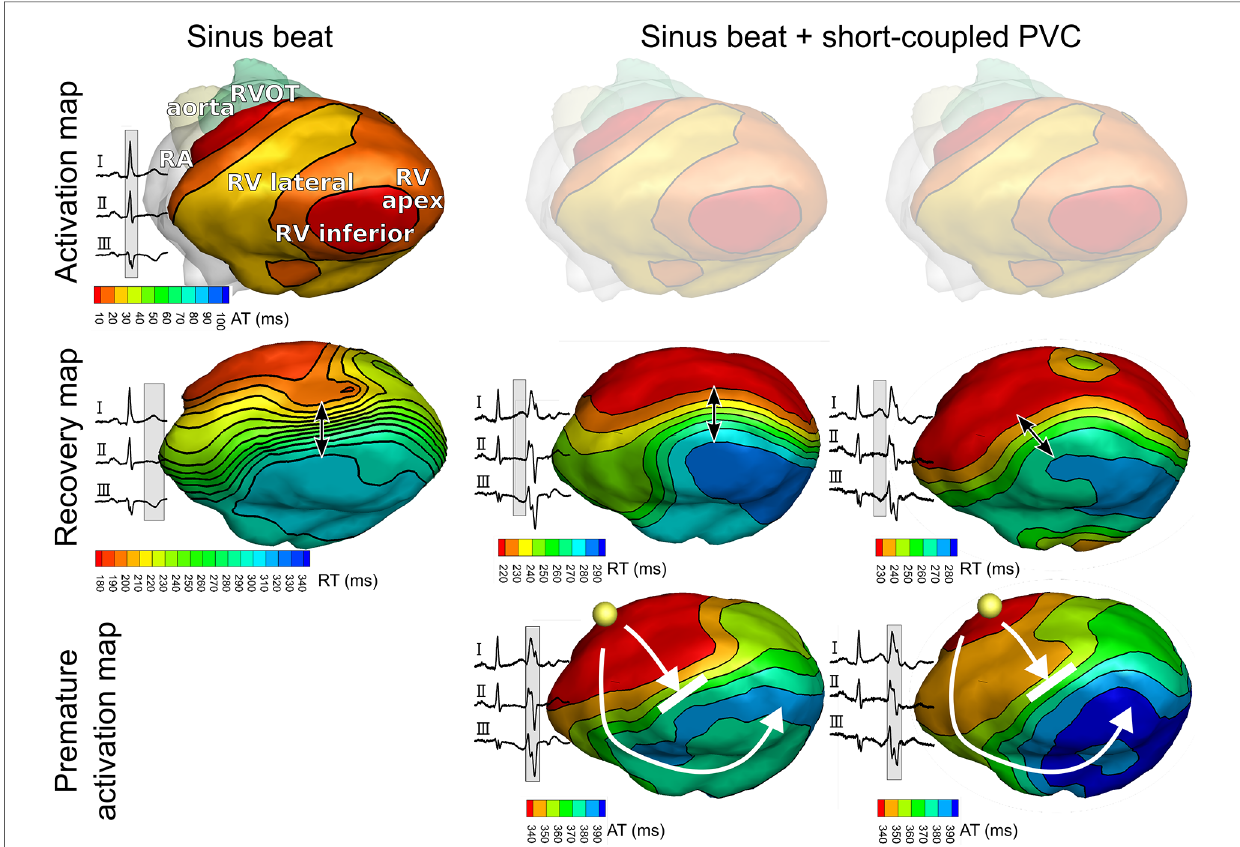
FIGURE 3 Noninvasively reconstructed epicardial isochrone maps for activation and recovery of sinus beats and premature ventricular complexes (PVCs). Epicardial isochrones show normal ventricular activation during sinus rhythm (row 1), but abnormal recovery (row 2) with steep repolarization time gradients (arrow). PVC activation (row 3) follows the pattern of recovery (row 2) of the preceding sinus beat. Yellow spheres in row 3 indicate the origin of